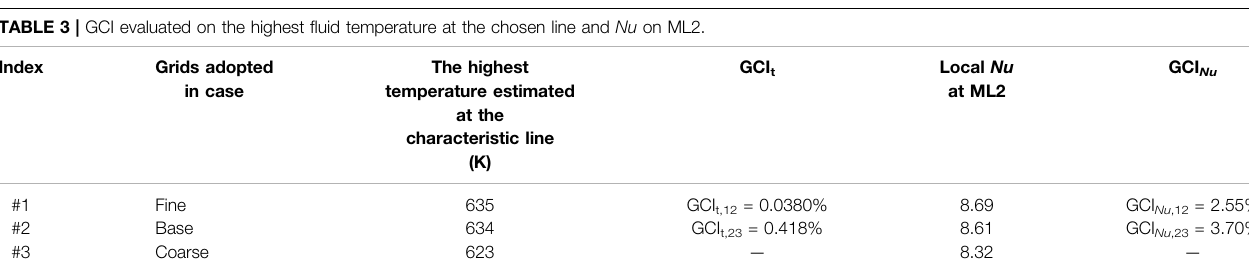
TABLE 3 | GCI evaluated on the highest fl uid temperature at the chosen line and Nu on